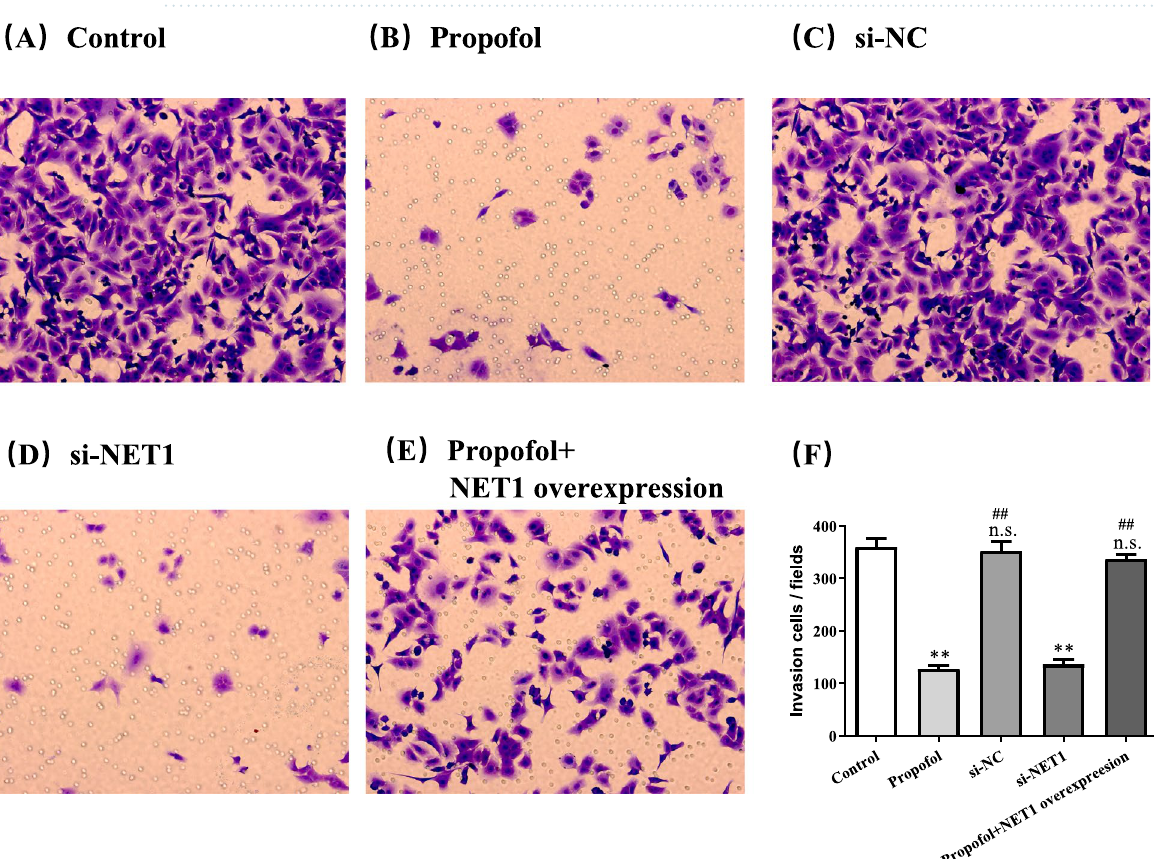
Figure 4. The treatment of 100 μM Propofol for 48 h (Panel B ) or NET1 silencing (Panel D ) significantly inhibited SMMC‑7721 cell invasion compared to control group (Panel A ) and NC group (Panel C ).While ( E ) the inhibitory effect of propofol was offset by NET1 overexpression (Panel E ). Statistical analysis on SMMC‑ 7721 cell invasion with indicted treatment (Panel F ). **P < 0.01 compared with control group, n.s. represented no significance compared with control group, # and ## denote P < 0.05, 0.01 compared with si‑NET1